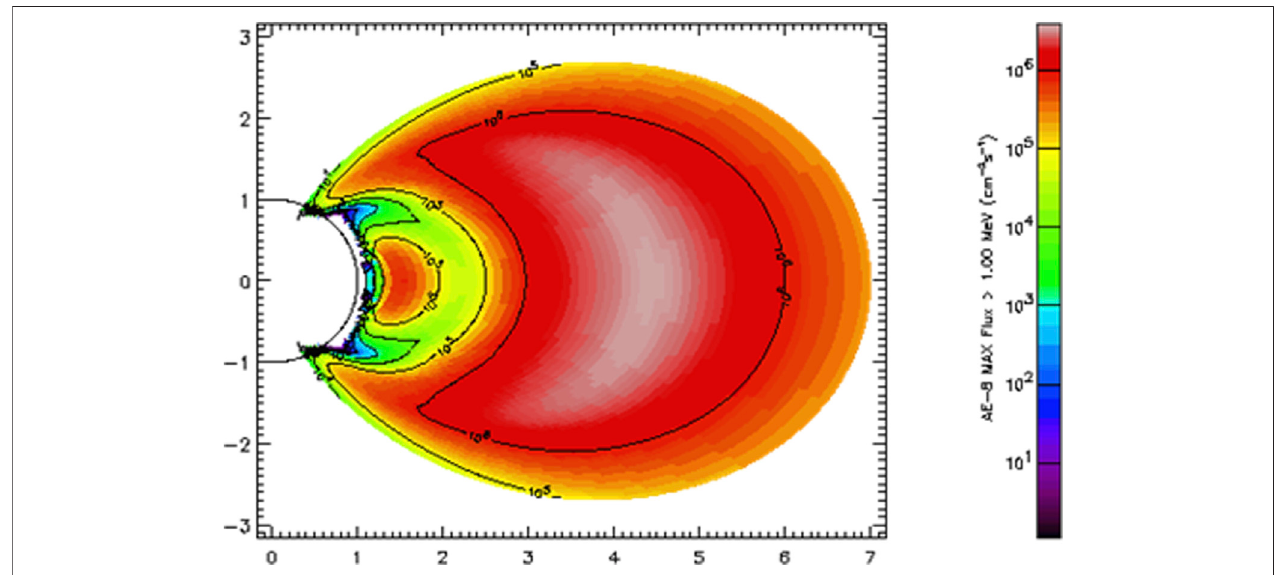
FIGURE 8 | Electron fl ux obtained with the empirical model AE-8MAX for 1